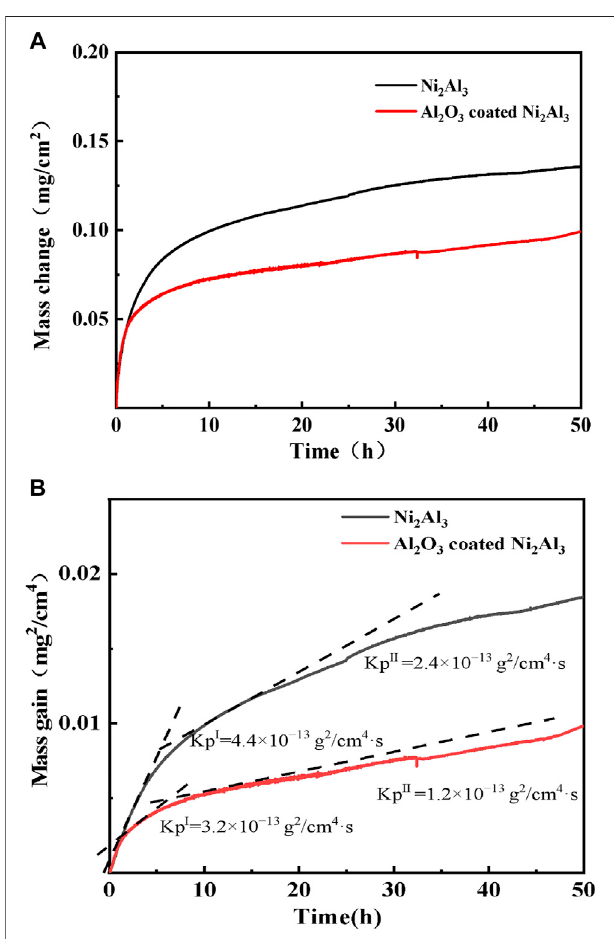
FIGURE 2 | (A) Oxidation kinetics curves and (B) corresponding parabolicplotsofnakedandAl